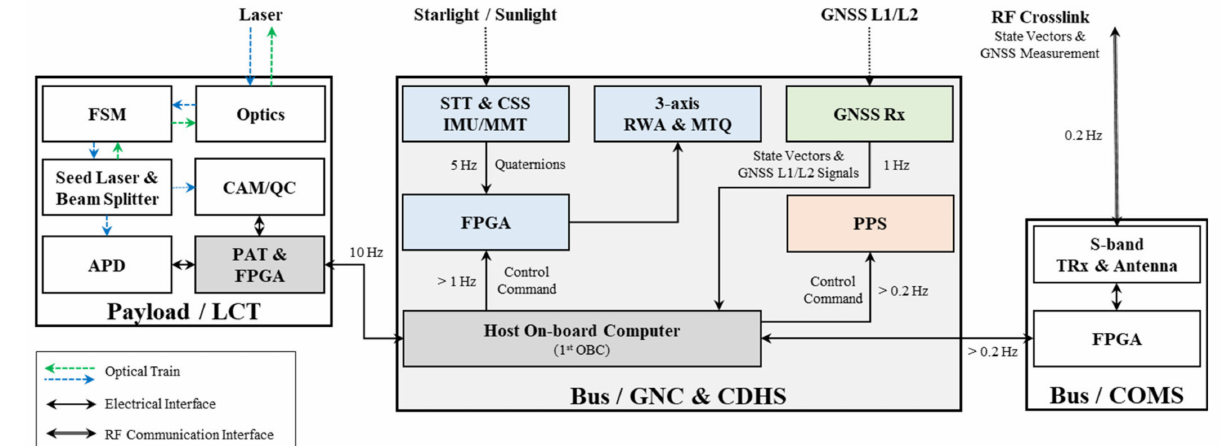
Figure 16. Diagram of the GNC architecture for formation flying. The host OBC commands the integrated attitude determination and control module for body pointing. During the PAT sequence, the LOS vector is yielded from the AOA and relative navigation, and the body pointing is executed faster than 1 Hz.